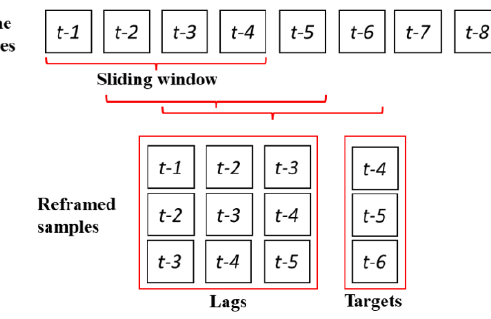
Figure 10. Transposing data from time format to supervised problem.